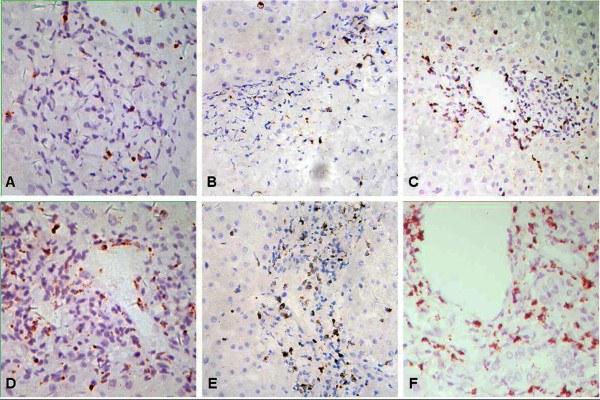
Immunostaining features of perforin, granzyme B and TIA-1 in the portal tract area. The expression of perforin (A), granzyme B (B) and TIA-1 (C) in the portal tract area in biopsies without ACR is sporadic and significantly less than that with ACR (D, E and F, respectively). (Immunostaining with hematoxylin counter staining, ×200).